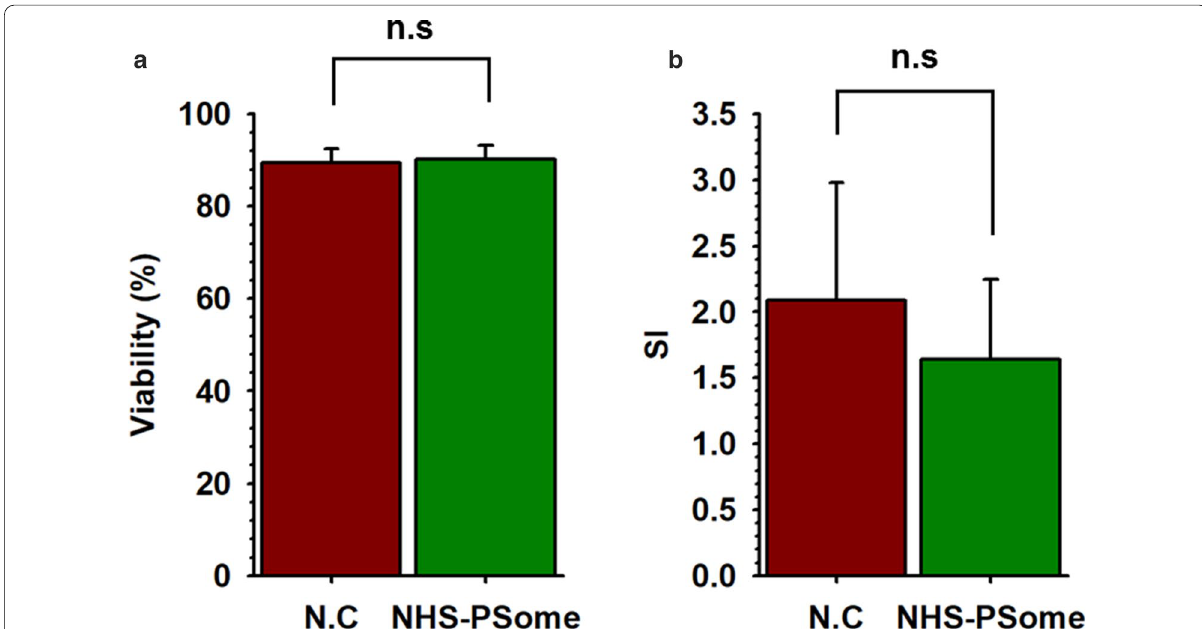
Fig. 4 Viability and functionality of NHS‑PSome nano‑encapsulated NPCCs using F‑10 with 0.25% BSA. a Viability of NHS‑PSome nano‑encapsulated NPCCs ( n